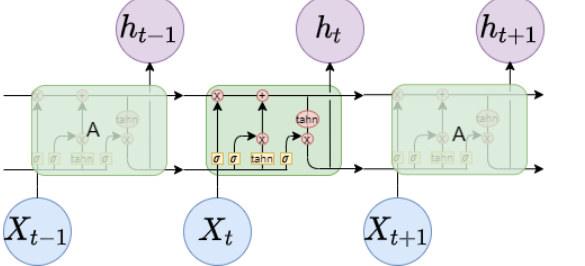
Figure 4. LSTM basic architecture